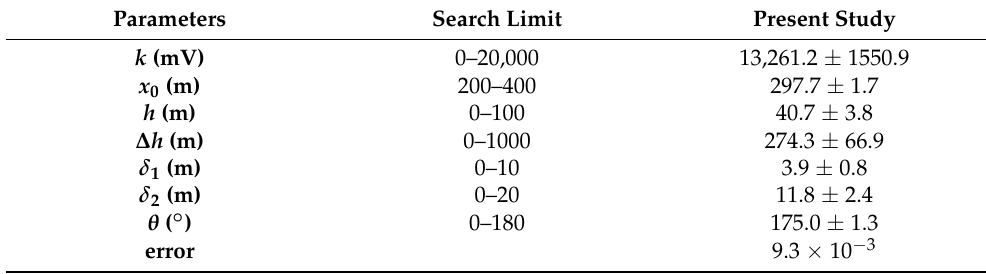
Table 5. Interpretation of Filizchai polymetallic deposit, Southern Greater Caucasus, Azerbaijan.